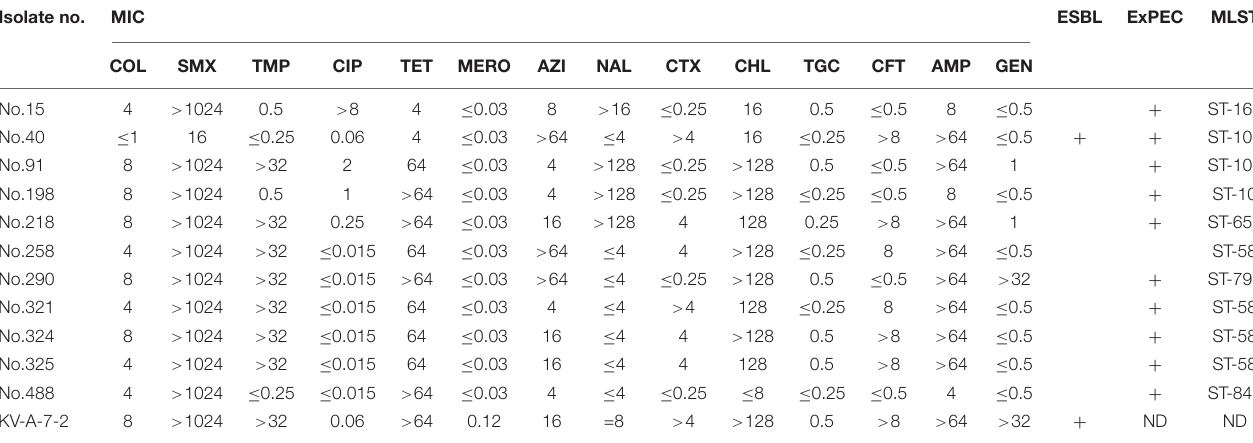
TABLE 4 | Antibiotic susceptibility based on minimum inhibitory concentration and the molecular characteristics of 12 mcr-1- positive E. coli isolates. Isolate no. ESBL